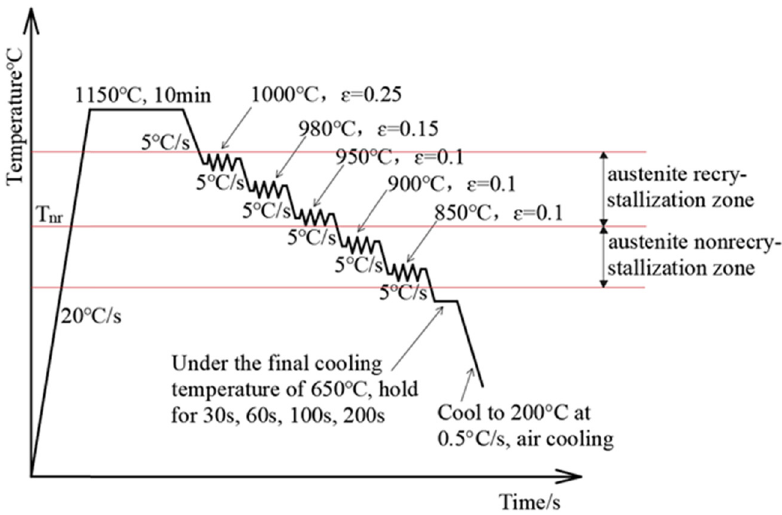
Figure 2: Thermal simulation process of the experimental